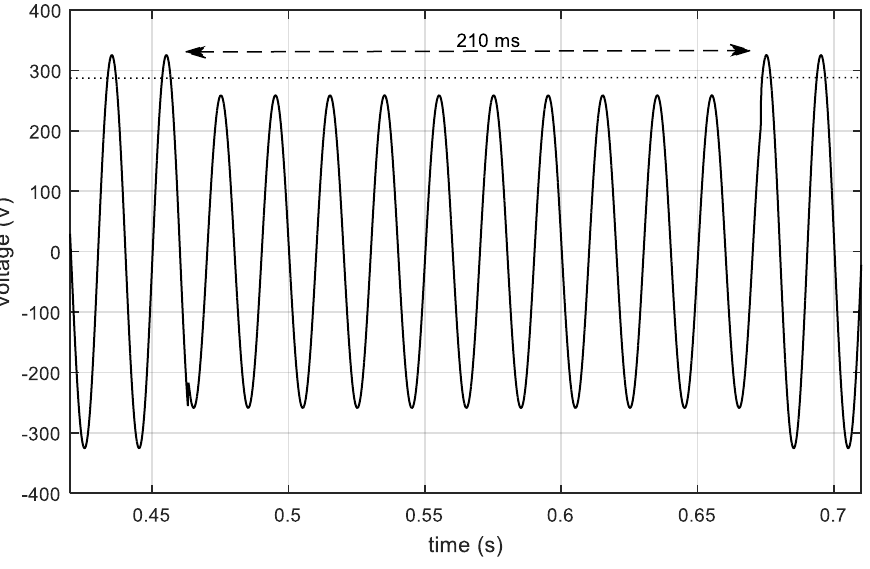
Figure 19. Example of Sag 2 (210 ms 79.6% V NOM ).